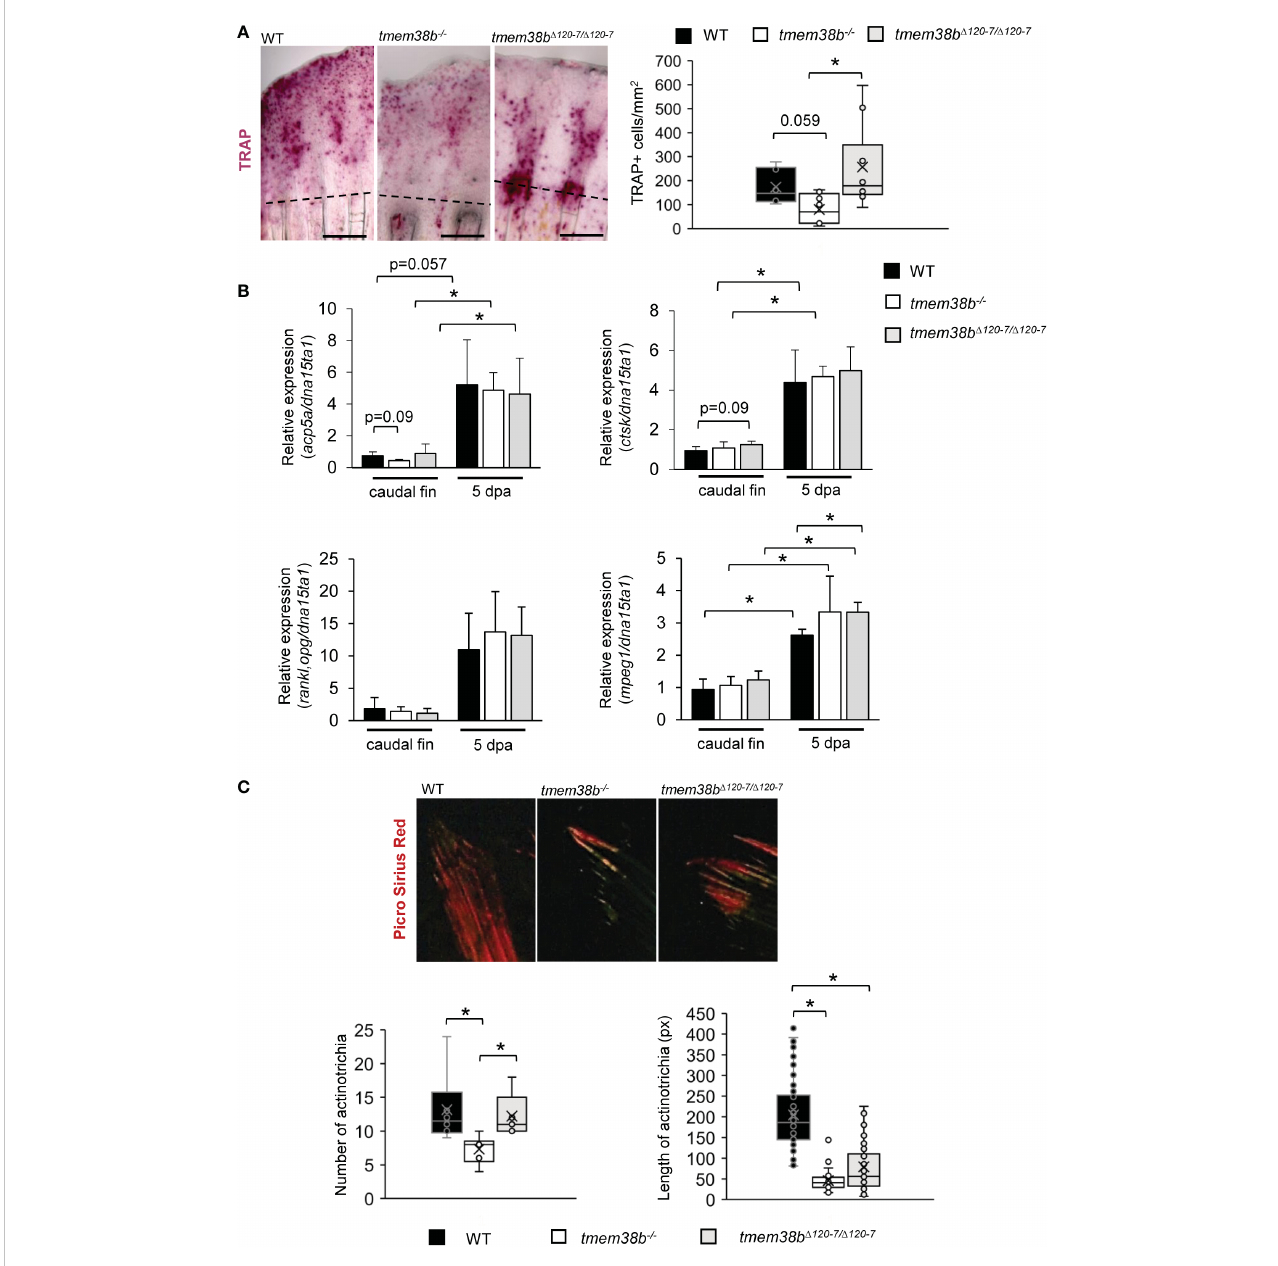
FIGURE 6 Osteoclast analysis during caudal fi n regeneration in tmem38b mutants. (A) Representative images of TRAP staining of caudal fi ns of WT and tmem38b mutants at 5 dpa (WT n = 7, tmem38b -/- n = 9, tmem38b D 120-7/ D 120-7 n = 10). In WT, osteoclasts were present in the regenerate. Almost no TRAP activity could be detected in tmem38b -/- , while in tmem38b D 120-7/ D 120-7 it seemed to be mostly localized along the regenerating fi n rays. TRAP+ cells were signi fi cantly reduced in tmem38b -/- respect to the other two groups. (B) Relative expression of bone resorption-related markers acp5a and ctsk , of the macrophage marker mpeg1 and rankl / opg ratio in amputated and 5 dpa caudal fi n (WT n = 3, tmem38b -/- n = 3, tmem38b D 120-7/ D 120-7 n = 3). All markers were increased after amputation. mpeg1 was signi fi cantly overexpressed in tmem38b D 120-7/ D 120-7 compared to WT at 5 dpa.*: p < 0.05. (C) Representative images of picro sirius red staining of actinotrichia in caudal fi ns of WT and tmem38b mutants (WT n = 3, tmem38b -/- n = 3, tmem38b D 120-7/ D 120-7 n = 3). tmem38b -/- revealed a reduced number of actinotrichia respect to WT and tmem38b D 120-7/ D 120-7 , while the length of actinotrichia was reduced in both mutants compared to WT. *p <